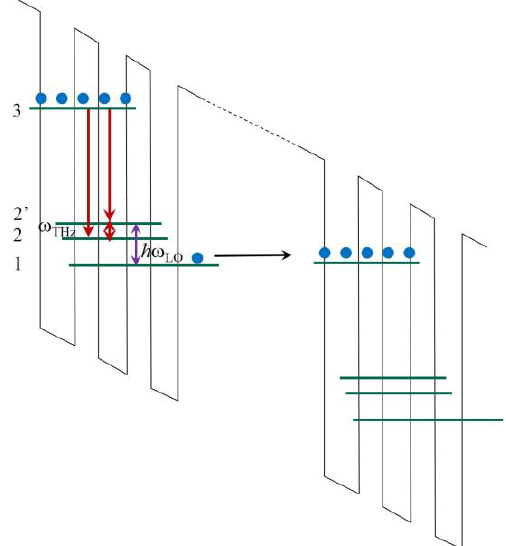
Figure 1. Schematic of the DFG process between the electron states in a band structure of quantum cascade laser.